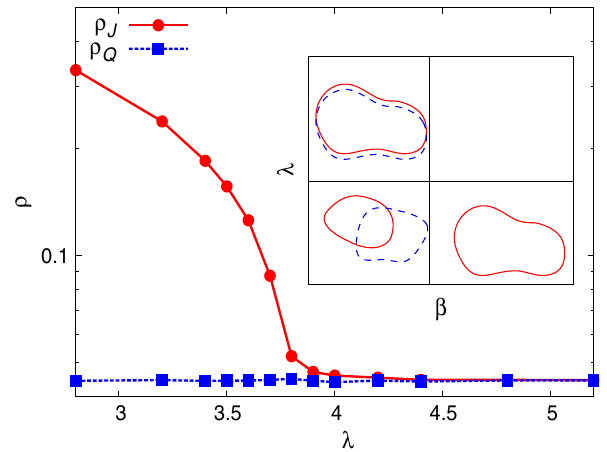
FIG. 1. Inset: Bulk phase diagram for the model in Eqs. (1) and (2) with bosons and Heisenberg spins. The phase diagram is mathematically equivalent to a system of decoupled currents and spins; hence, the straight line boundaries. At λ ¼ 0 , the system has a paramagnet-ferromagnet transition as β is increased, while the bosons are superfluid throughout. As λ is increased, the boson currents bind to the hedgehog currents. The loop pictures in the phases show a “ snapshot ” of the phase. Red solid loops mean that boson currents are proliferated in the phase, while blue dashed loops indicate proliferated hedgehog currents. The phase of interest is the “ binding ” phase in the upper left-hand corner where bosons are bound to hedgehogs. The main figure shows the current-current correlations of the bosons and hedgehogs as λ is increased while β ¼ 0 , for a system of linear dimension L ¼ 6 . We see that the correlators become essentially equal as the system enters the upper left phase, indicating that bosons have bound to